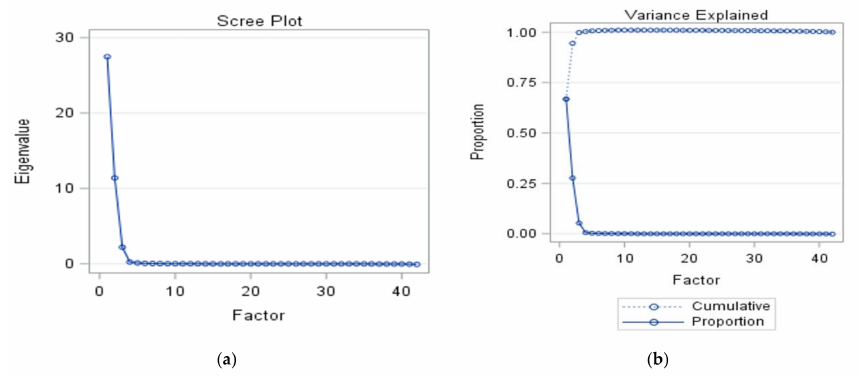
Figure 14. Scree plot ( a ) Eigenvalue vs. factors and ( b ) proportion vs. factors: four factors are retained by the PROPORTION criterion.